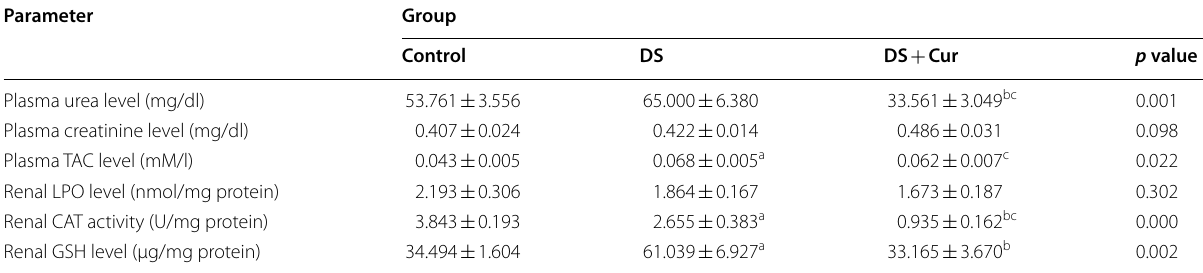
Results are expressed as mean SEM (6 mice/group) ± Data are analyzed by one-way ANOVA followed by Duncan posttest DS Diclofenac sodium; Cur curcumin; TAC total antioxidant capacity; LPO lipid peroxides; CAT catalase; GSH reduced glutathione a indicates significant difference between control and DS groups at p < 0.05 b indicates significant difference between DS and DS Cur groups at p < 0.05 + c indicates significant difference between control and DS Cur groups at p < +